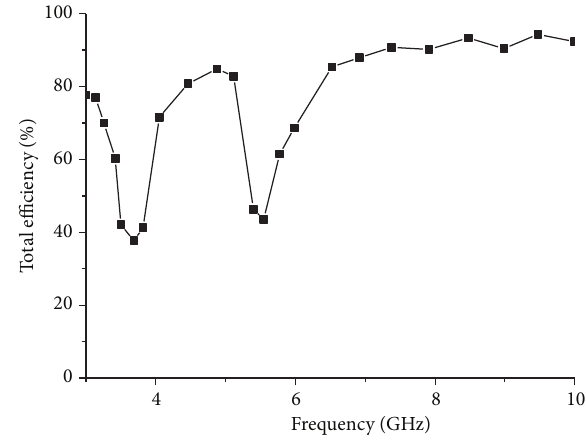
Figure 22: Total efficiency versus